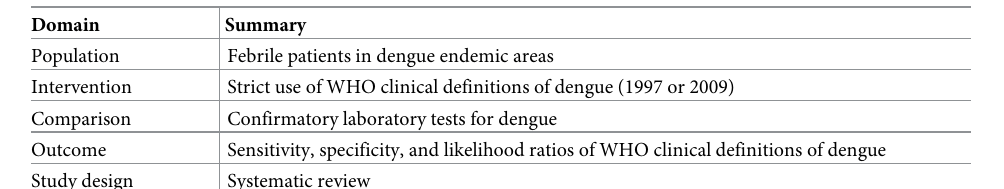
Table 1. PICOS statement.